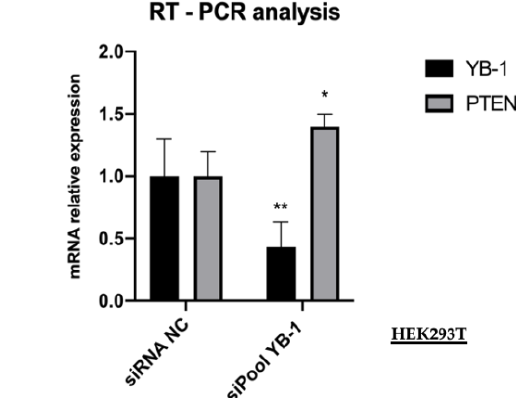
Figure 4. YB-1 depletion increases the level of PTEN transcript. HaCaT and HEK293T cells were transfected with 10 nM final siRNA-poolYB-1 or siNC; the effect on PTEN mRNA level was evaluated 48h post-transfection by qRT-PCR analysis. Relative mRNA levels were plotted on the y-axis and siRNA employed are indicated on the x-axis. RPL0 ribosomal protein mRNA was used for normalization. Statistical analyses were performed using 2- way ANOVA and Sidak’s multiple com- parison test. Levels of significance between points of expression are indicated (*** p < 0.001, ** p < 0.01, * p < 0.05).